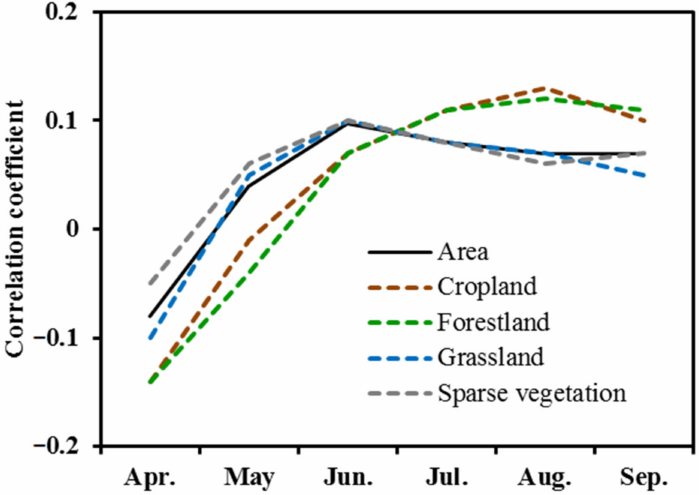
Figure 8. Average correlation coefficients between winter snowfall and monthly NDVI for different land-cover types and the whole study